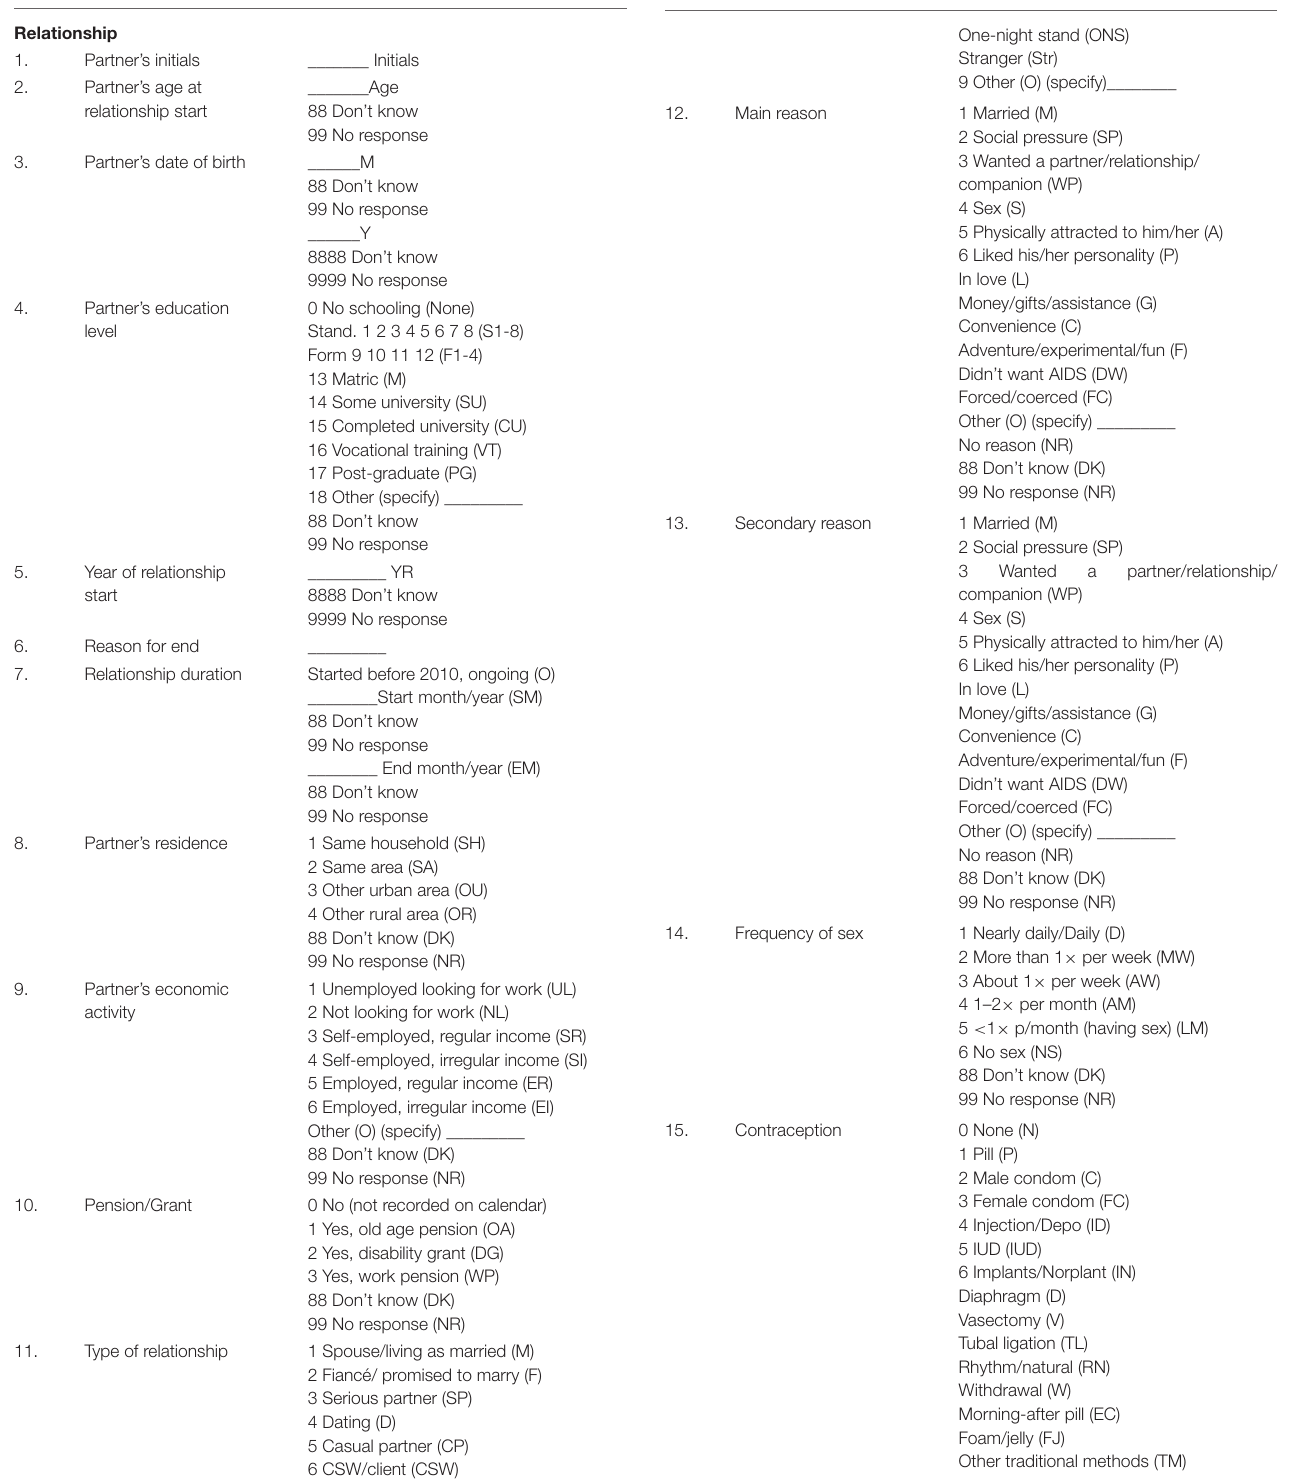
TABLE 2 | Questionnaire related to Relationship